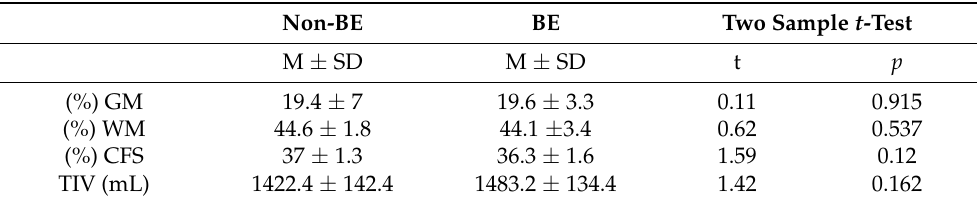
Table 2. Global Volumes: between-groups comparison for global volumes values (gray matter, white matter, cerebrospinal fluid) and total intracranial volume